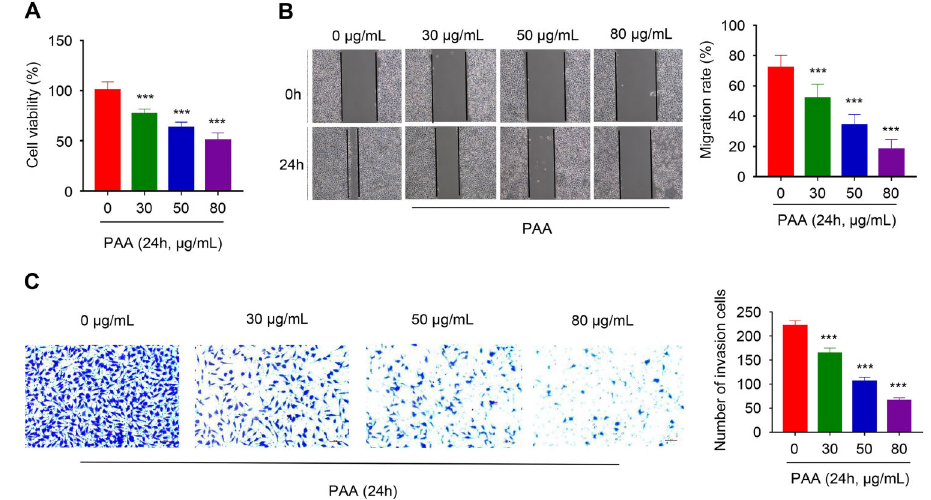
Figure 1. Poricoic acid A (PAA) suppressed the proliferation, migration, and invasion of SKOV3 cells. A , CCK-8 assay of cell proliferation on SKOV3 cells treated with 0, 30, 50, and 80 m g/mL PAA for 24 h. B , Scratch cell migration assay of cells treated with different concentrations of PAA at 0 and 24 h. C , Transwell invasion assay of cells treated with different concentrations of PAA for 24 h (scale bar 50 m m). Data are reported as means ± SD of 3 independent experiments. ***P o 0.001 compared to Control (0 m g/mL) (two-tailed Student ’ s t